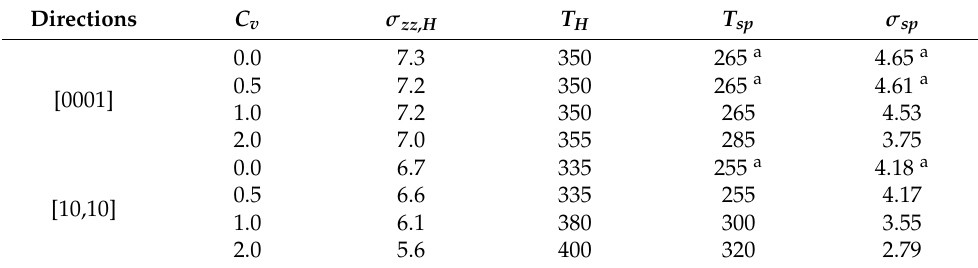
Table 1. Shock and spall parameters of Mg with different initial vacancy concentrations C v (%). The steady shock or Hugoniot state is denoted by the subscript H. Values listed are the shock stress, σ zz,H (GPa), the shock temperature, T H (K), the spall temperature, T sp (K) and the spall strength, σ sp (GPa). Directions C v σ